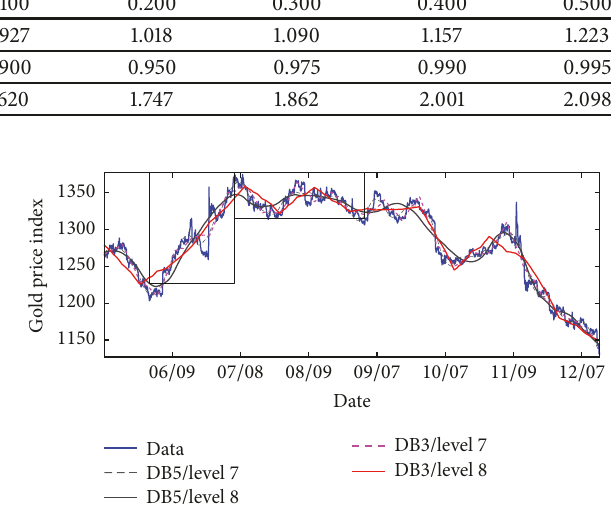
Figure 6: Moving 𝑉 𝑛 (𝑡, 𝑠) -statistic checked out by wavelet